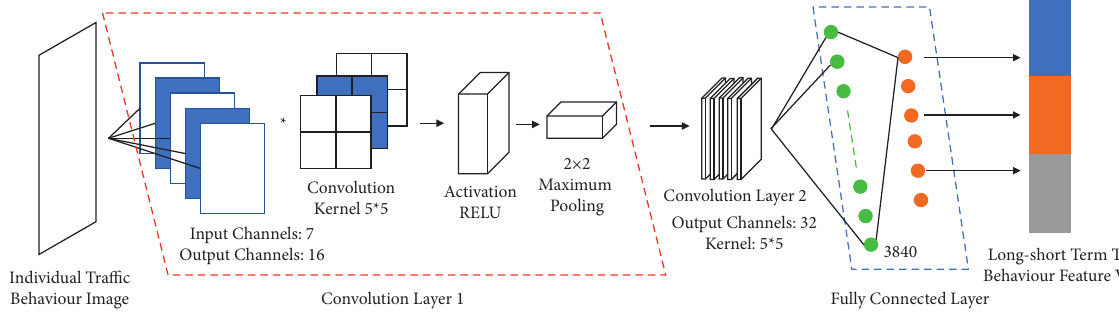
Figure 6: Long short-term travel traffic behaviour feature vector extraction network based on CNN.